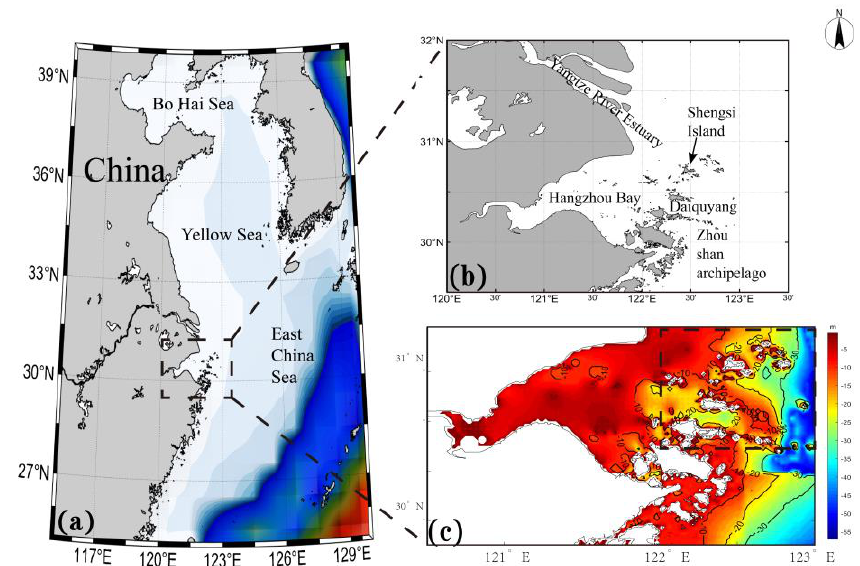
Figure 1. ( a ): Location of Hangzhou Bay, Black square in ( a ): Hangzhou Bay. ( b ): Shengsi and its surroundings. ( c ): The water depth topographic map of Hangzhou Bay, in which the black square represents the study area.